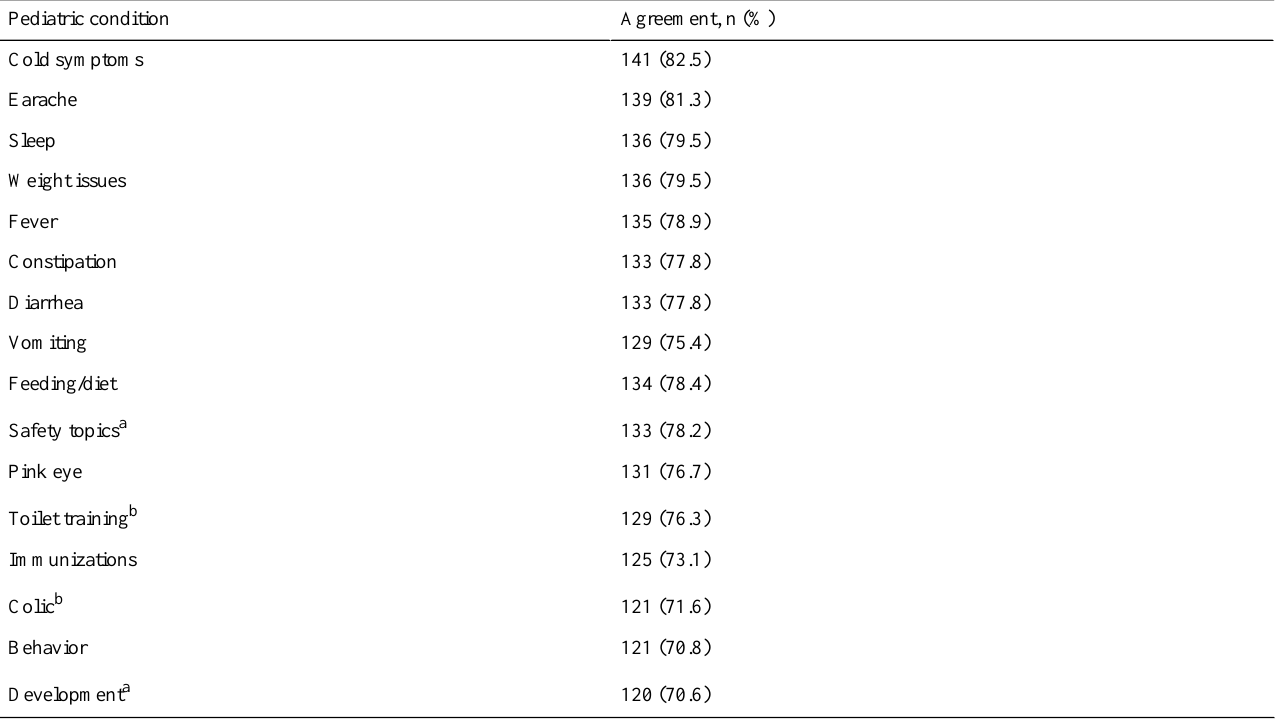
Table 4. Email communication to discuss common pediatric conditions